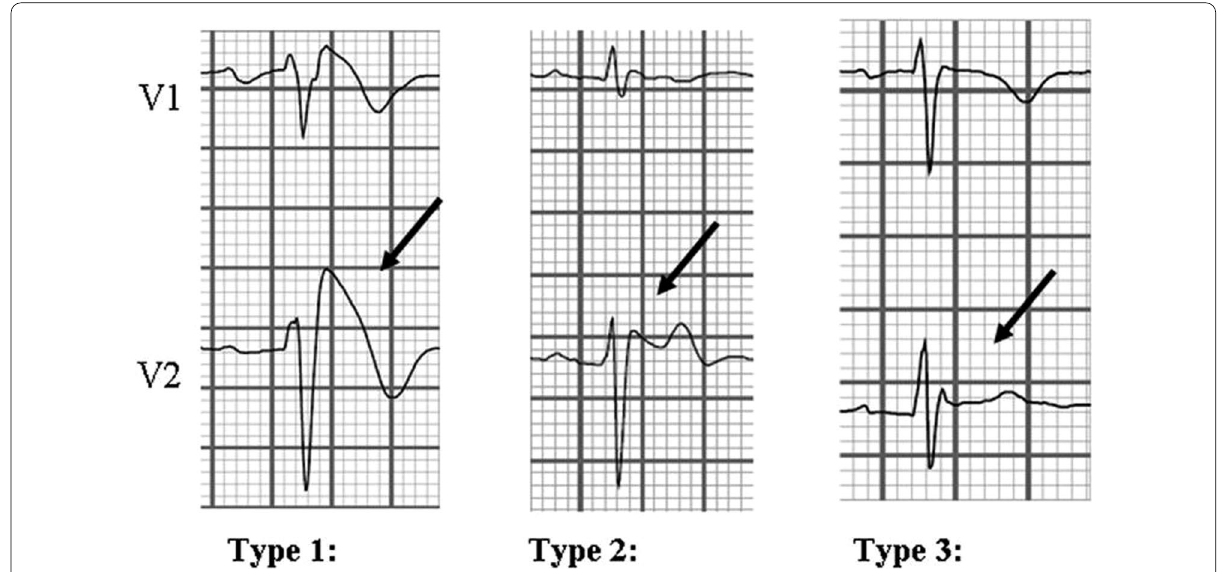
Fig. 1 Illustration of 3 patterns of Brugada syndrome (published under CC BY‑NC 3.0 license)